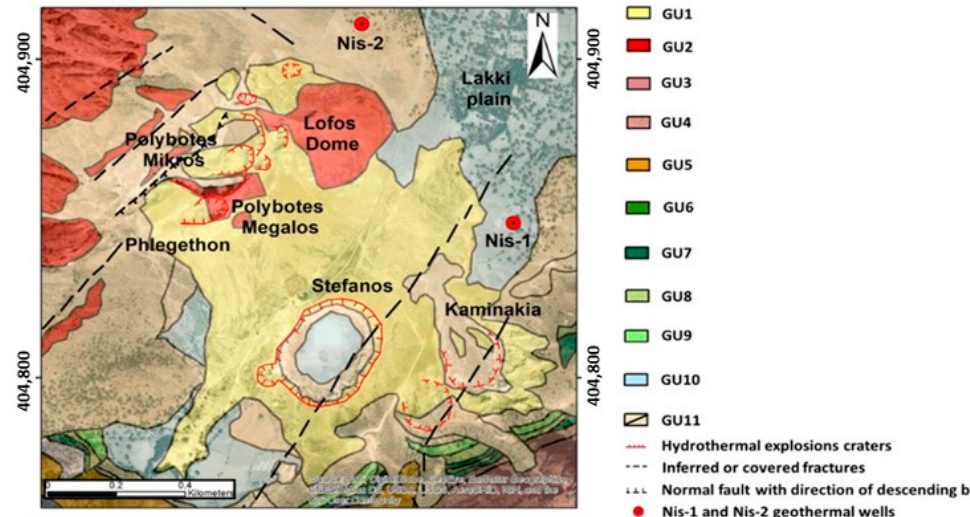
Figure 2. Digitized extract of the geological map of Nisyros (sheet “Map of the Island of Nisyros (Dodecanese Archipelago)”) focusing on the caldera hydrothermal field (scale 1:15,000) [68] with its legend. The lithostratigraphic units (LSU1 to LSU11) are presented in detail in the main text. There are five main hydrothermal craters, the two areas of Lofos dome (epithermal gold deposits) and Lakki plain. Nis-1 and Nis-2 correspond to the location of two official geothermal wells [73,74]. The background image is the Sentinel-2 MSI image.